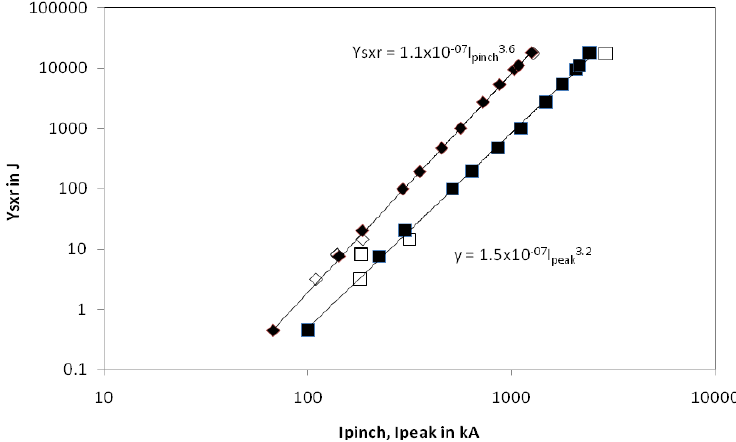
and I . The parameters kept constant for pinch peak = 30nH and V = 20 kV and model 0 0 and V 0 0